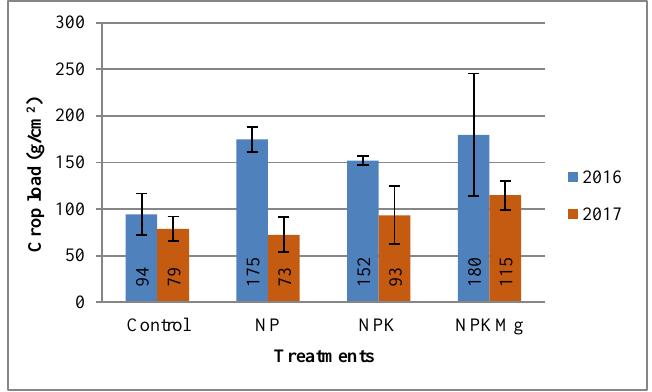
Figure 2 . Crop load of sweet cherry cultivar ‘Carmen’ (Debrecen-Pallag, 2016-2017). Cultivar ‘Carmen’ is one of the largest fruit-sized Hungarian sweet cherry cultivar. Comparing the two years, fruit diameter was larger in 2016 (32.9-34.6 mm) in all treatments despite the higher crop load values ( Figure 3 ). In 2017, differences in fruit size was more balanced among the treatments (31.4-32.7 mm), the smallest diameter was recorded in control treatment.